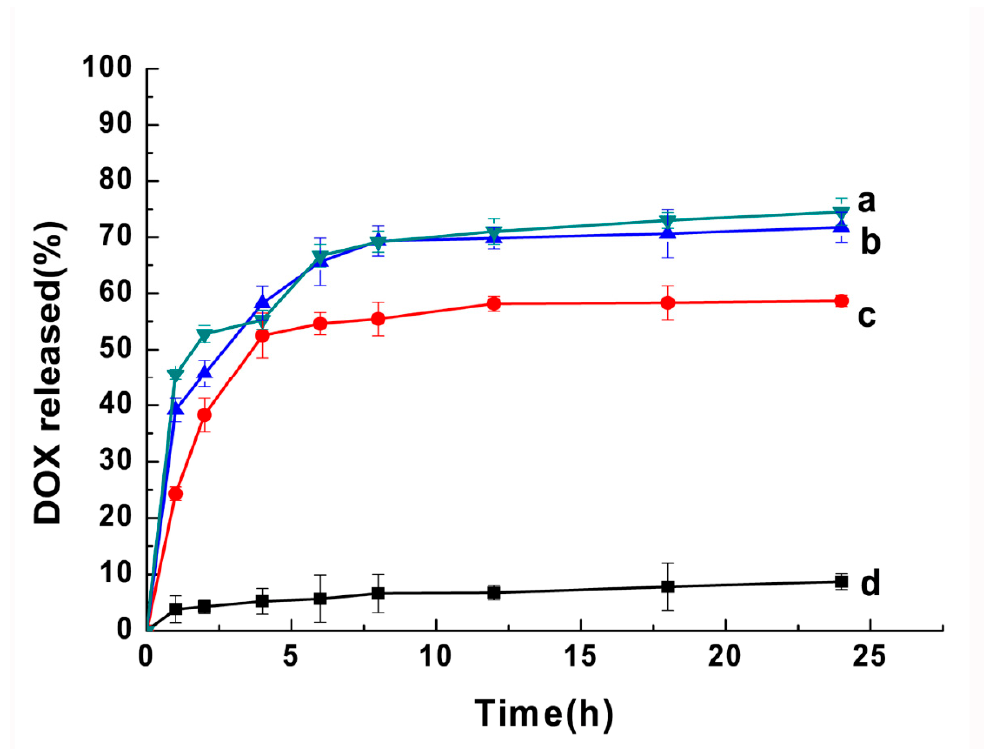
Figure 5. In vitro drug release profile of the nanoparticles. The AP-PP-DOX nanoparticles were incubated with PBS ( d ) or matrix metalloproteinase 2 (MMP2) at 10 nM ( c ), 20 nM ( b ), and 40 nM ( a ). Data were expressed as the mean ± SD.